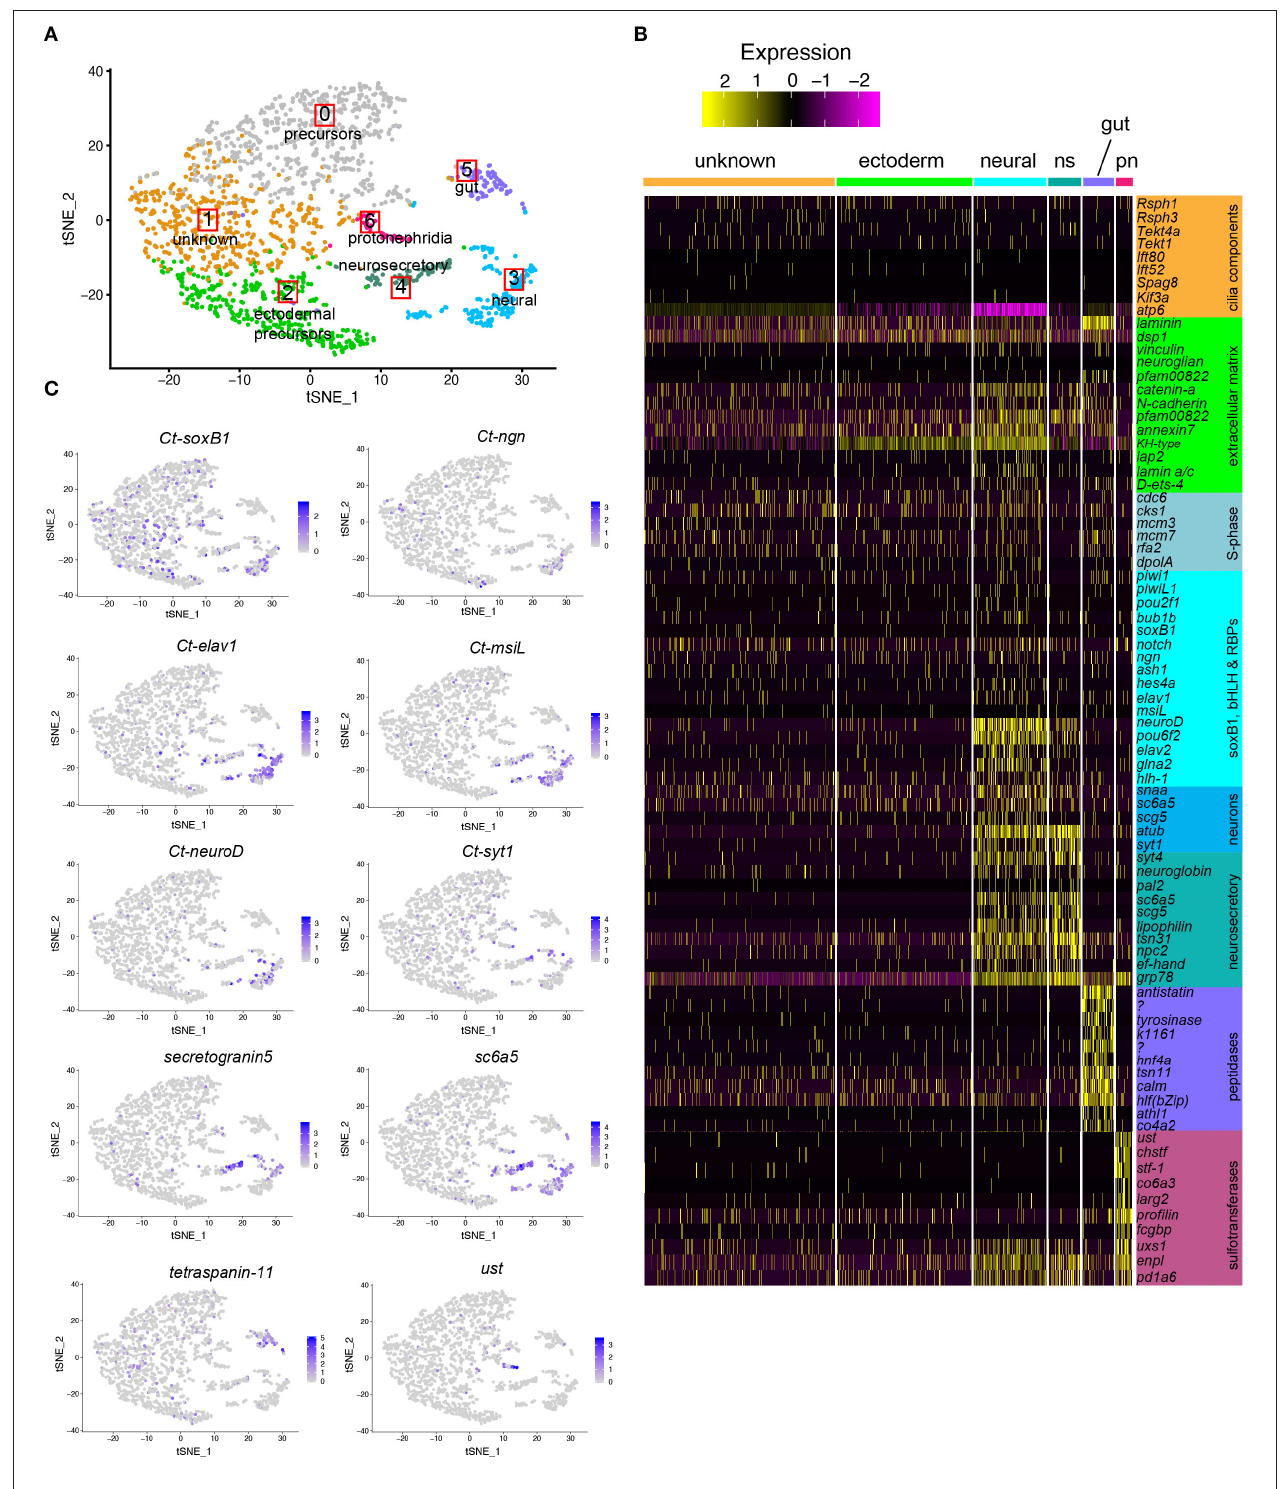
FIGURE 4 | Single-cell molecular landscape of stage 5 C. teleta larvae. (A) t-SNE representation of stage 5 larval single cells with clusters labeled by transcriptional identities. (B) Cell type specific marker genes reflect cellular identities and functions. Heatmap showing log normalized differentially expressed genes per molecular domain identified. Each row represents a single gene whereas each column represents a cell. (C) t-SNE plots of cells colored by expression of selected marker genes that were used for identifying each cluster. The color key indicates expression levels (purple: high; gray: low). ns, neurosecretory; pn, protonephridia.